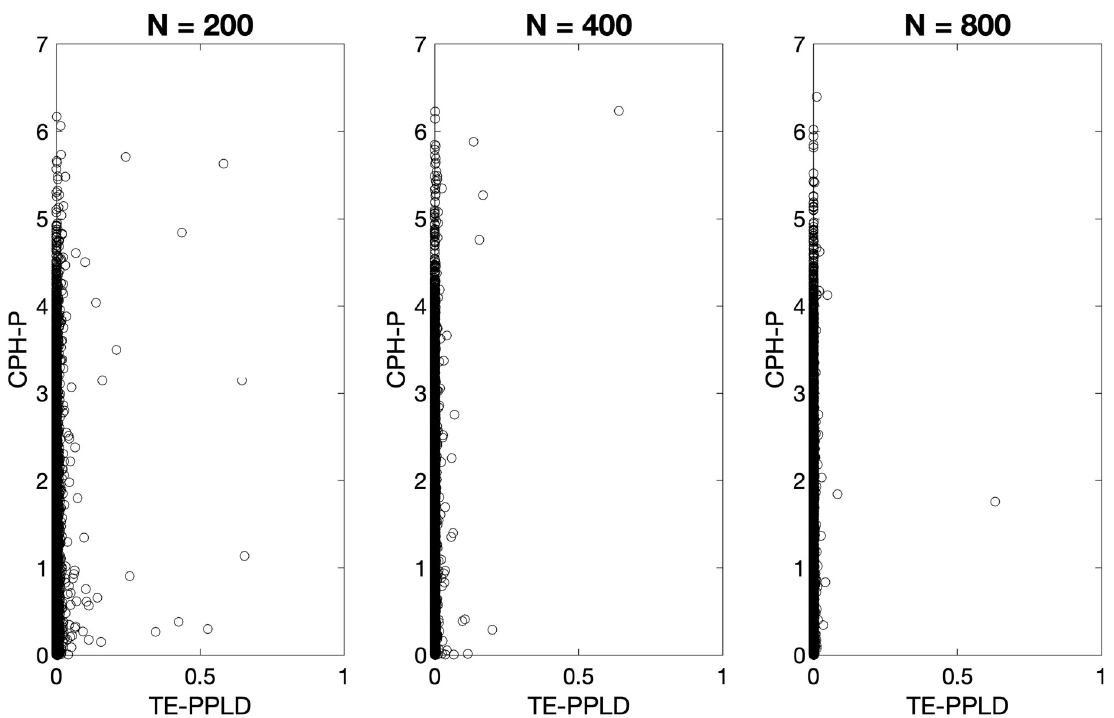
Fig 1. Comparative behavior of CPH-P, TE-PPLD under H 0 as a function of sample size N. Shown here are scatter plots of the CPH-P and TE-PPLD distributions at three different sample sizes N, across 1,000,000 replicates generated independently for each N under H 0 : “no SNP-trait